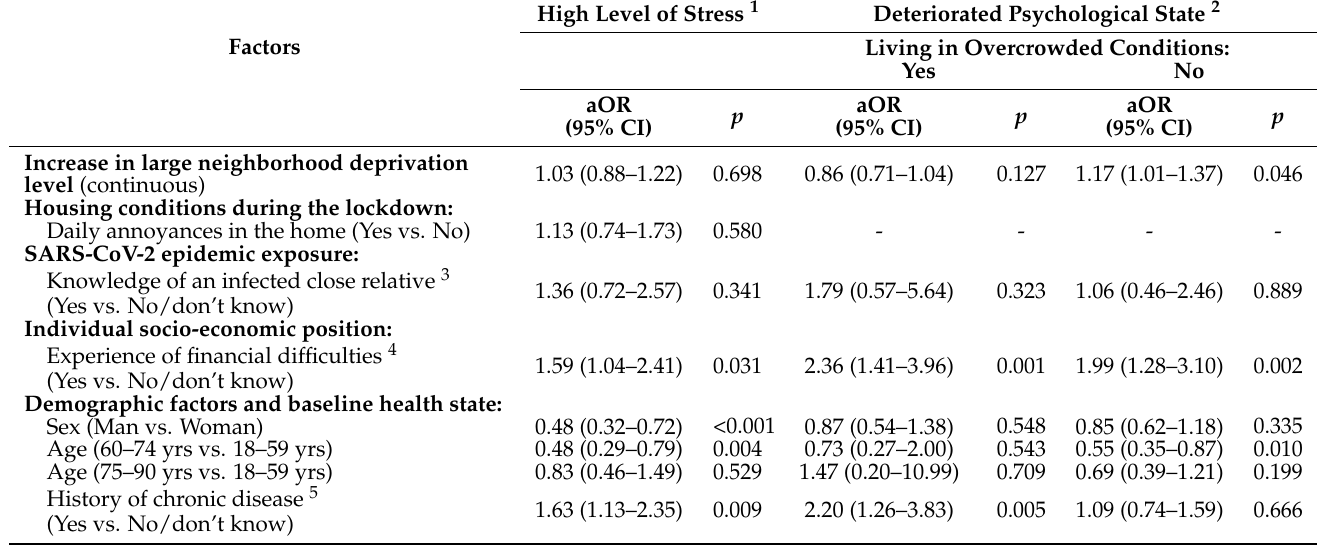
Table 3. Factors independently associated with negative mental health endpoints in the adult population during the COVID-19 lockdown (R é -Conf-ISS cross-sectional study: Reunion Island, 13 May and 22 July 2020)—fully adjusted multivariable models